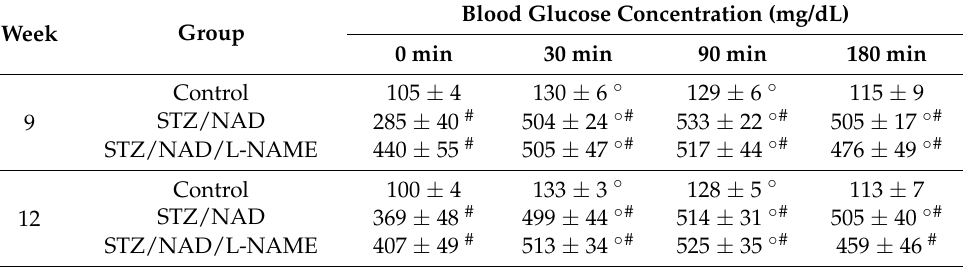
Table 1. Blood glucose concentrations during glucose tolerance test in diabetic and control rats. Glucose (2 g/kg) was administered via oral gavage (0 min), and blood glucose was measured after 30, 90, and 180 min. Data are presented as mean ±